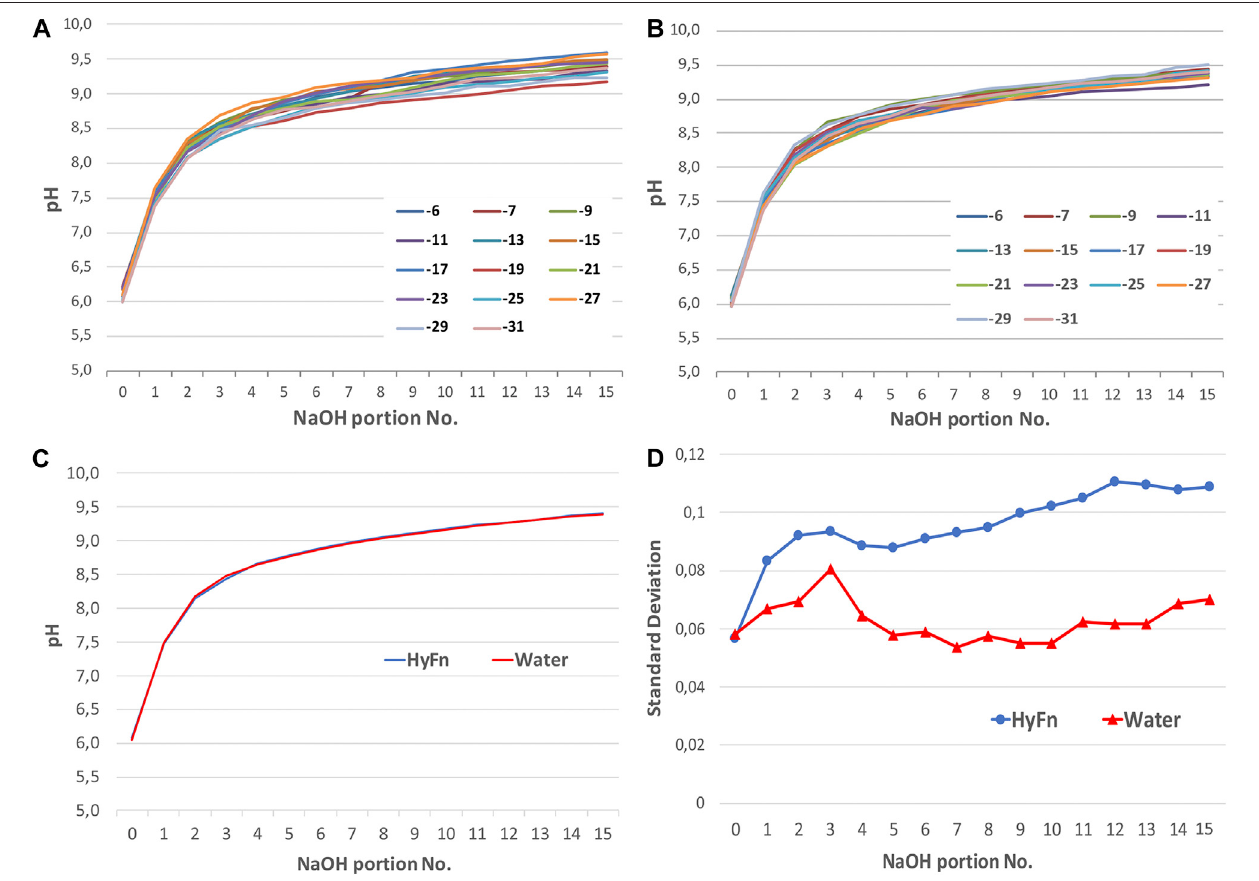
FIGURE 4 | Typical examples of titration curves of (A) series No 2 (out of 5) of HyFn dilutions and (B) of series No 2 (out of 3) of “ dilutions ” of water (from 10 – 6 to 10 – 31 M) with NaOH. The abscissa represents numbers of the portions of NaOH (10 μ L) added to the titrated samples, the ordinate is pH value. Each line on (A, B) represents a particular dilution of HyFn or water “ dilution ” corresponding to calculated HyFn molar concentrations indicated in the plots as lg [HyFn], M. (C) Averaged titration curves of all HyFn dilutions and water “ dilutions ” for all series of experiments. (D) Standard deviations from the mean pH values averaged over all series of experiments, varying during the titration of HyFn dilutions and water “ dilutions ” (from 10 – 7 to 10 – 31 M) with NaOH.